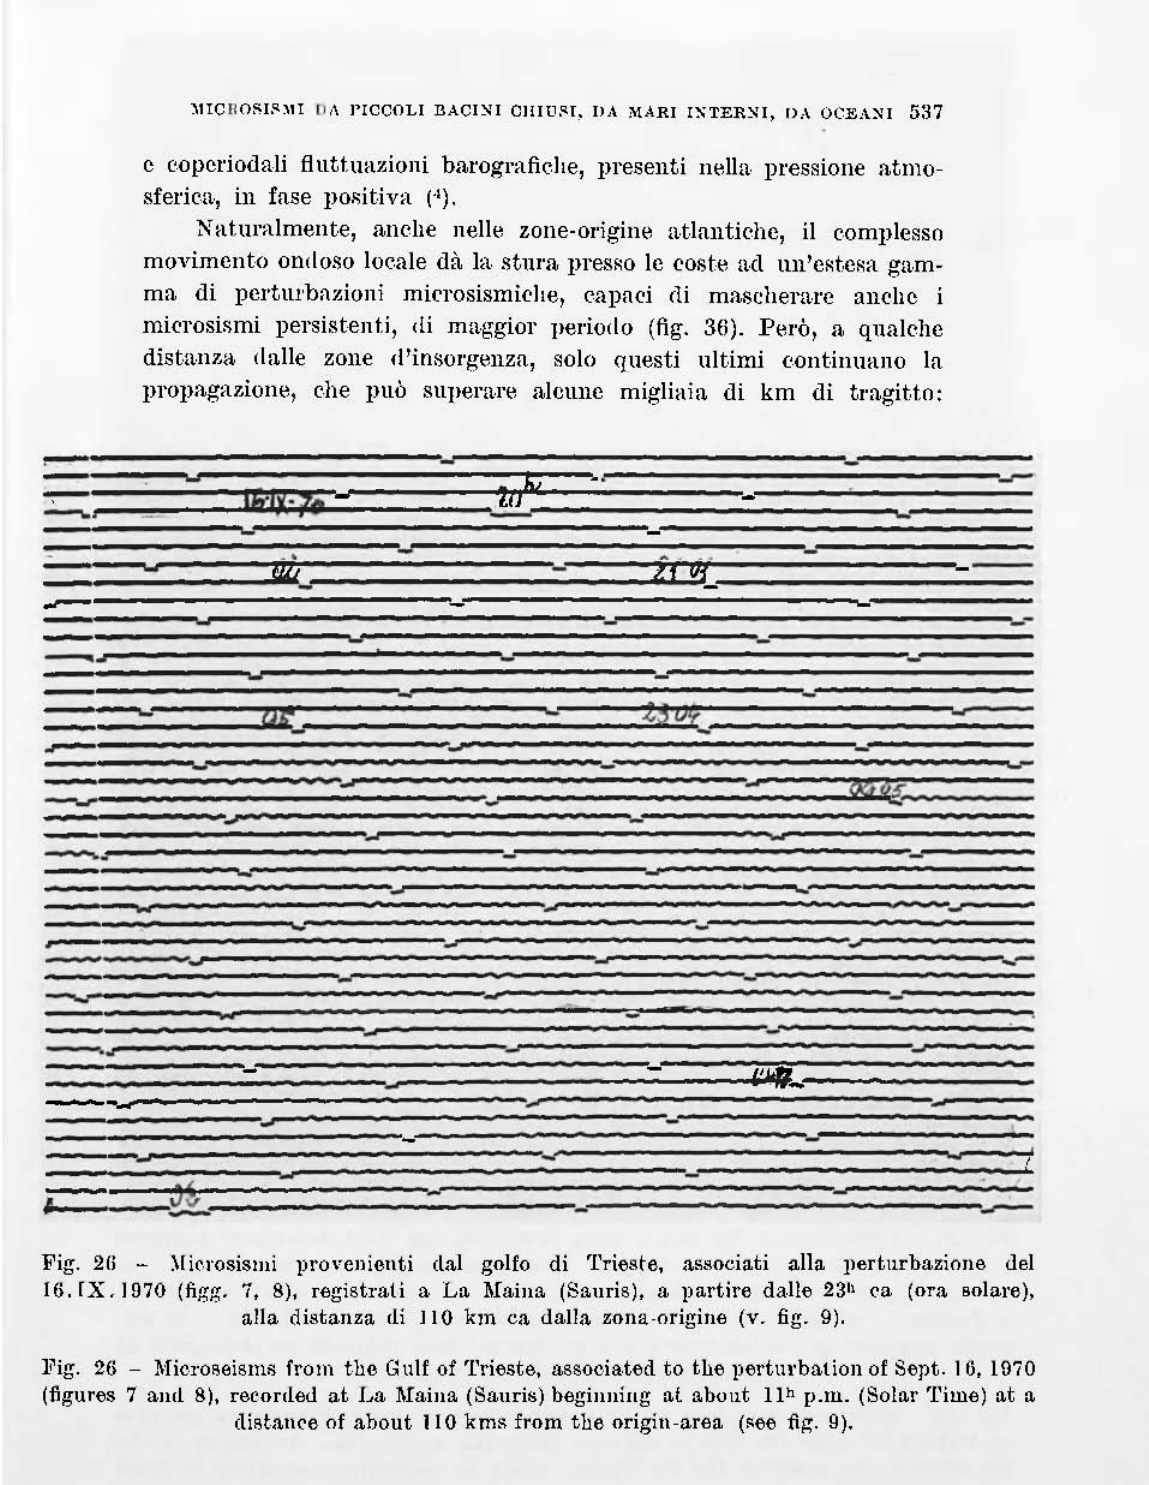
Fig. 2(; ~Ikrosisllli llrovcnienti (Lal golfo di Trieste, associati alla llertllrbazione del 16. IX . 1970 (figg. 7, 8), registrati a La ?!faina (Sauris), a lJartire da.lle 2311 ca (ora solare), alla distanza (li IlO km ca dalla zona·origine (v. fig. 9). li'ig. 26 1IicroseisIllS frolll tbe Gnlf of Trieste, associated to tbe llertnrbation of Sept. 16, 1070 (figures 7 ami 8), reconled at La ?!faina (Sauris) beginning al. abuut 11 h p.m. (SolaI' 'l'ime) at a (listallcc of about 110 kms from tbe origin-area (~ee ng.